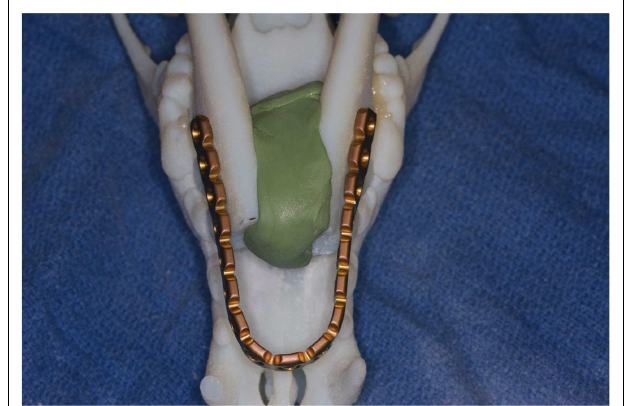
FIGURE 1 | Surgical planning on a 3D printed skull demonstrating the adjustment and adaptation of the titanium locking plate to the model of the rostral mandibles